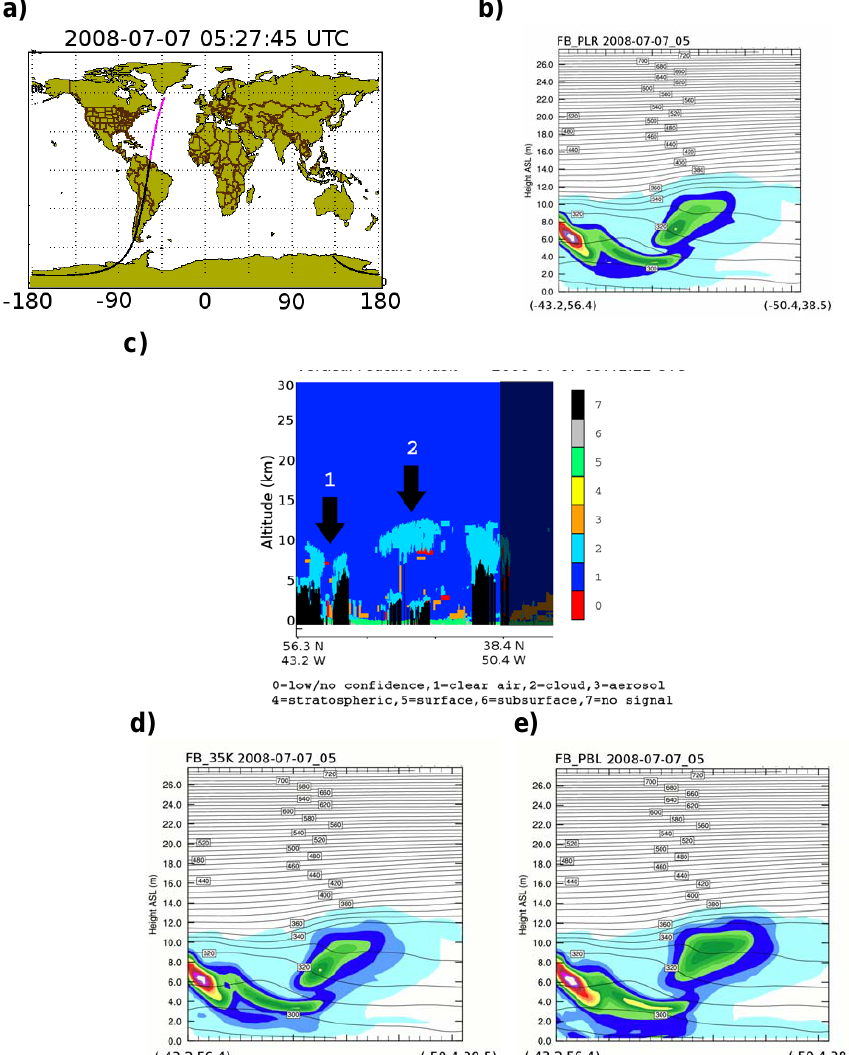
Fig. 16. a) Map of CALIPSO path at 0527 UTC 7 July 2008 with analyzed segment over the Atlantic Ocean in violet and b) CALIOP vertical feature mask (VFM). Normalized WRF aerosol plume for b) Fig. 16. (a) Map of CALIPSO path at 05:27 UTC 7 July 2008 with analyzed segment over the Atlantic Ocean in violet and (b) CALIOP FB_PLR, d) FB_35K, and e) FB_PBL along the CALIPSO track. This is a descending overpass; vertical feature mask (VFM). Normalized WRF aerosol plume for (b) FB PLR, (d) FB 35K, and (e) FB PBL along the CALIPSO track. north is to the left Arrows in c) indicate features discussed in the text. This is a descending overpass; north is to the left. Arrows in (c) indicate features discussed in the text. Numerous previous studies have released emissions between the surface and the top of the planetary boundary layer (e.g., Fisher et al., 2010; Leung et al., 2007; Hyer et al.,